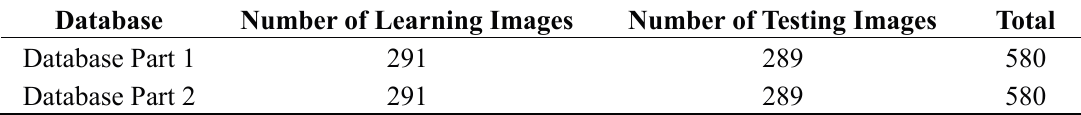
Figure 16. Sample images from PAL database: ( a ) male aged 22; ( b ) female aged 49; ( c ) male aged 52; ( d ) female aged 67 and ( e ) female aged 78. Table 2. Descriptions of PAL database and its learning and testing